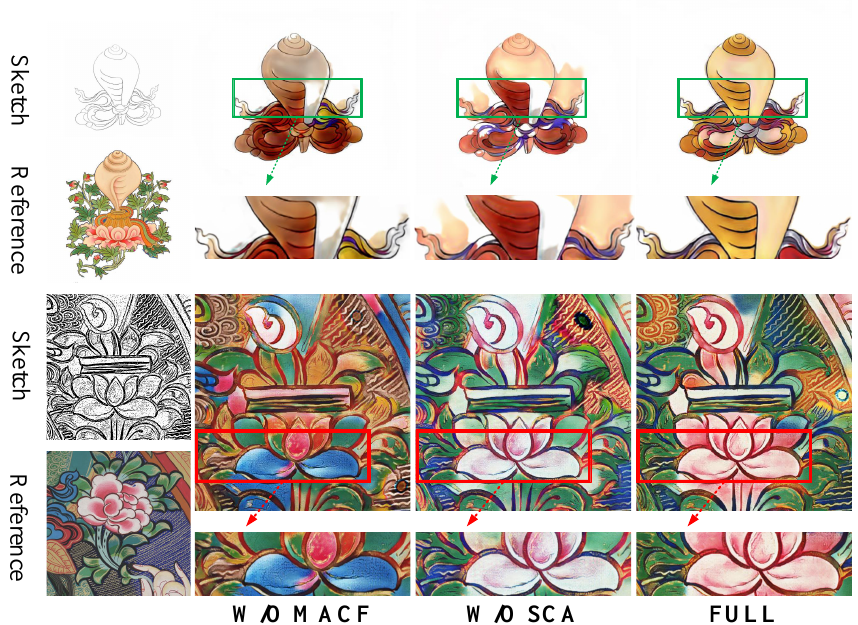
Figure 7. The proposed multi-level adaptive-instance-normalized color fusion (MACF) and skip connection attention (SCA) allow our MACF-SCA to produce visually better and more accurate colorization results by multi-level color fusion (see the fourth column). In contrast, the second column (without MACF strategy) shows obvious color confusion. In the third column (without SCA strategy), it is not difficult to find color errors due to misjudgment of line semantic